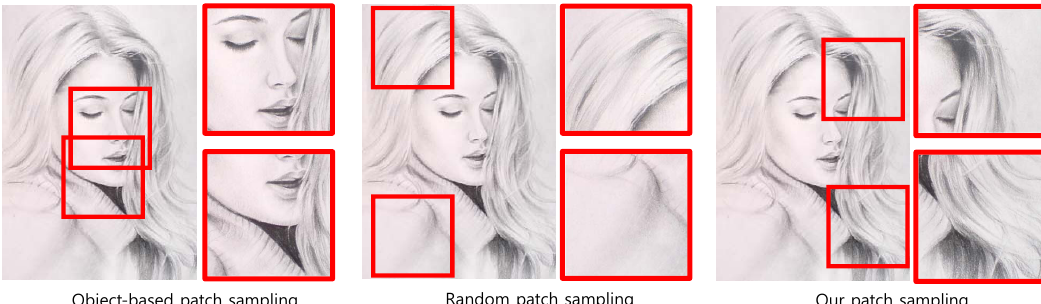
Figure 16. Comparison of three sampling